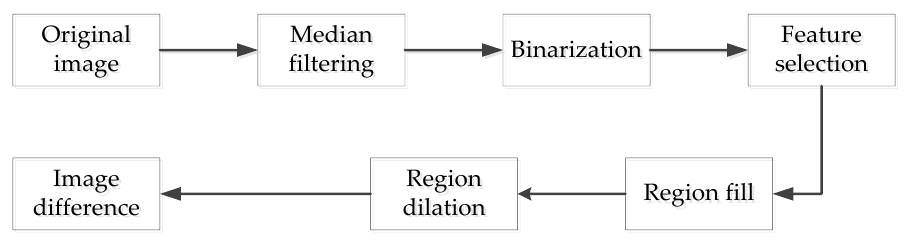
Figure 8. Image preprocessing flow chart.